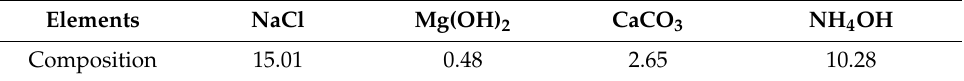
Table 3. Chemical composition of the synthetic district heating water (mg /